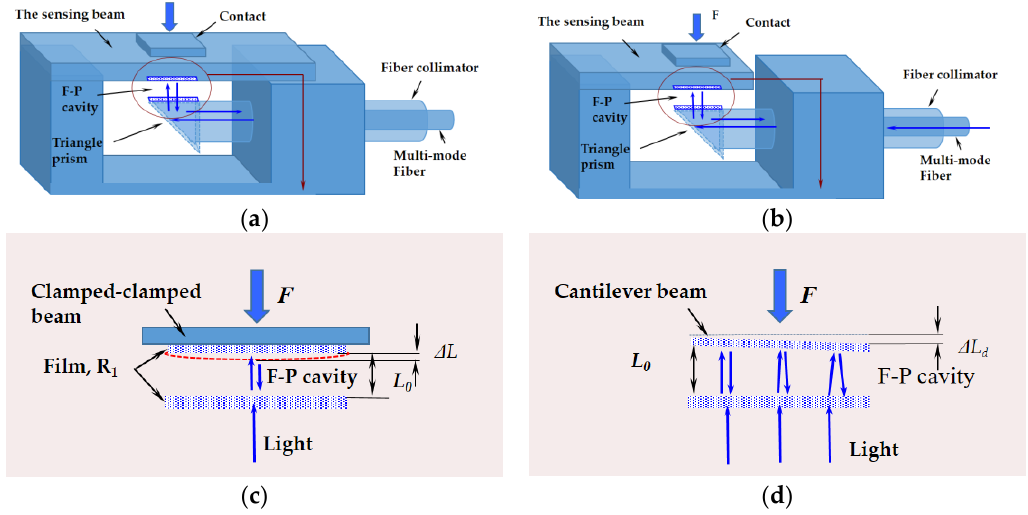
Figure 2. Three-dimensional structure of our Fabry-Perot (F-P) force sensors with ( a ) clamped-clamped beam element; ( b ) cantilever beam element; a simplified structure of the F-P cavity length change induced by the force F for ( c ) a clamped-clamped beam; ( d ) a cantilever beam.